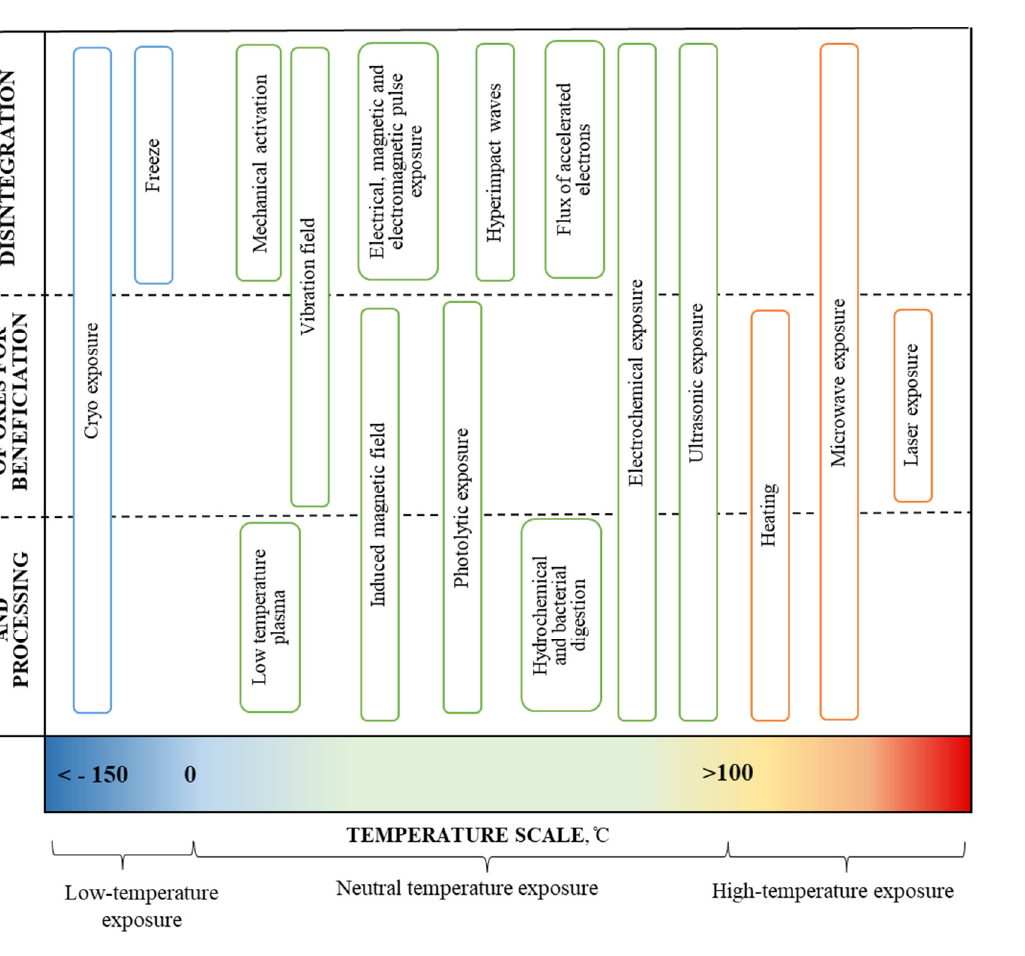
Figure 1. Energy and physical and chemical exposures at the successive stages of mineral transfor- mation. Table 1. Systematization of energy and physical and chemical exposures in preparation, beneficia- tion and processing of ores.